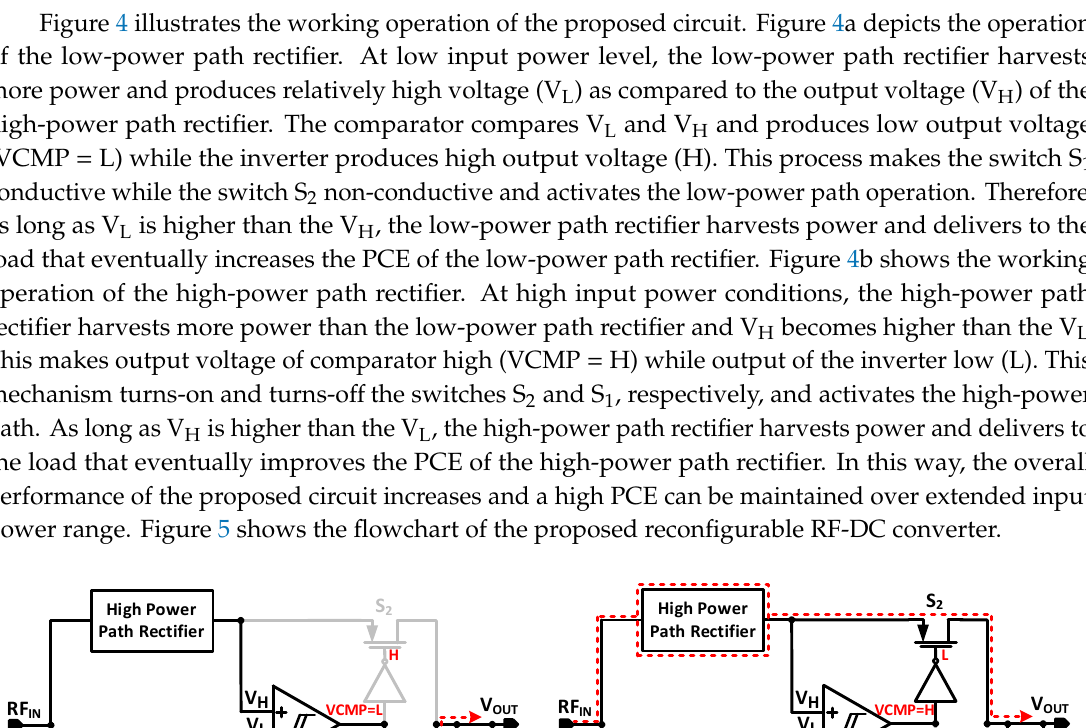
Figure 3. Block diagram of the proposed RF-DC converter.